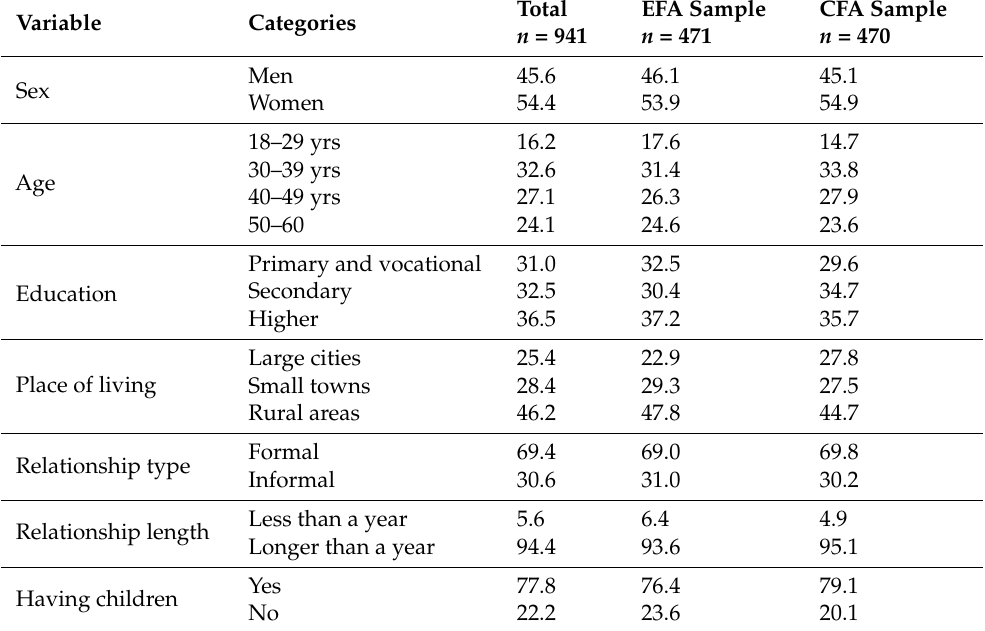
Table 1. Sample characteristics (all data presented as percentages). The two smaller datasets were created from the whole set of data by a random permutation of the respondents’ order and then dividing the permuted dataset into two